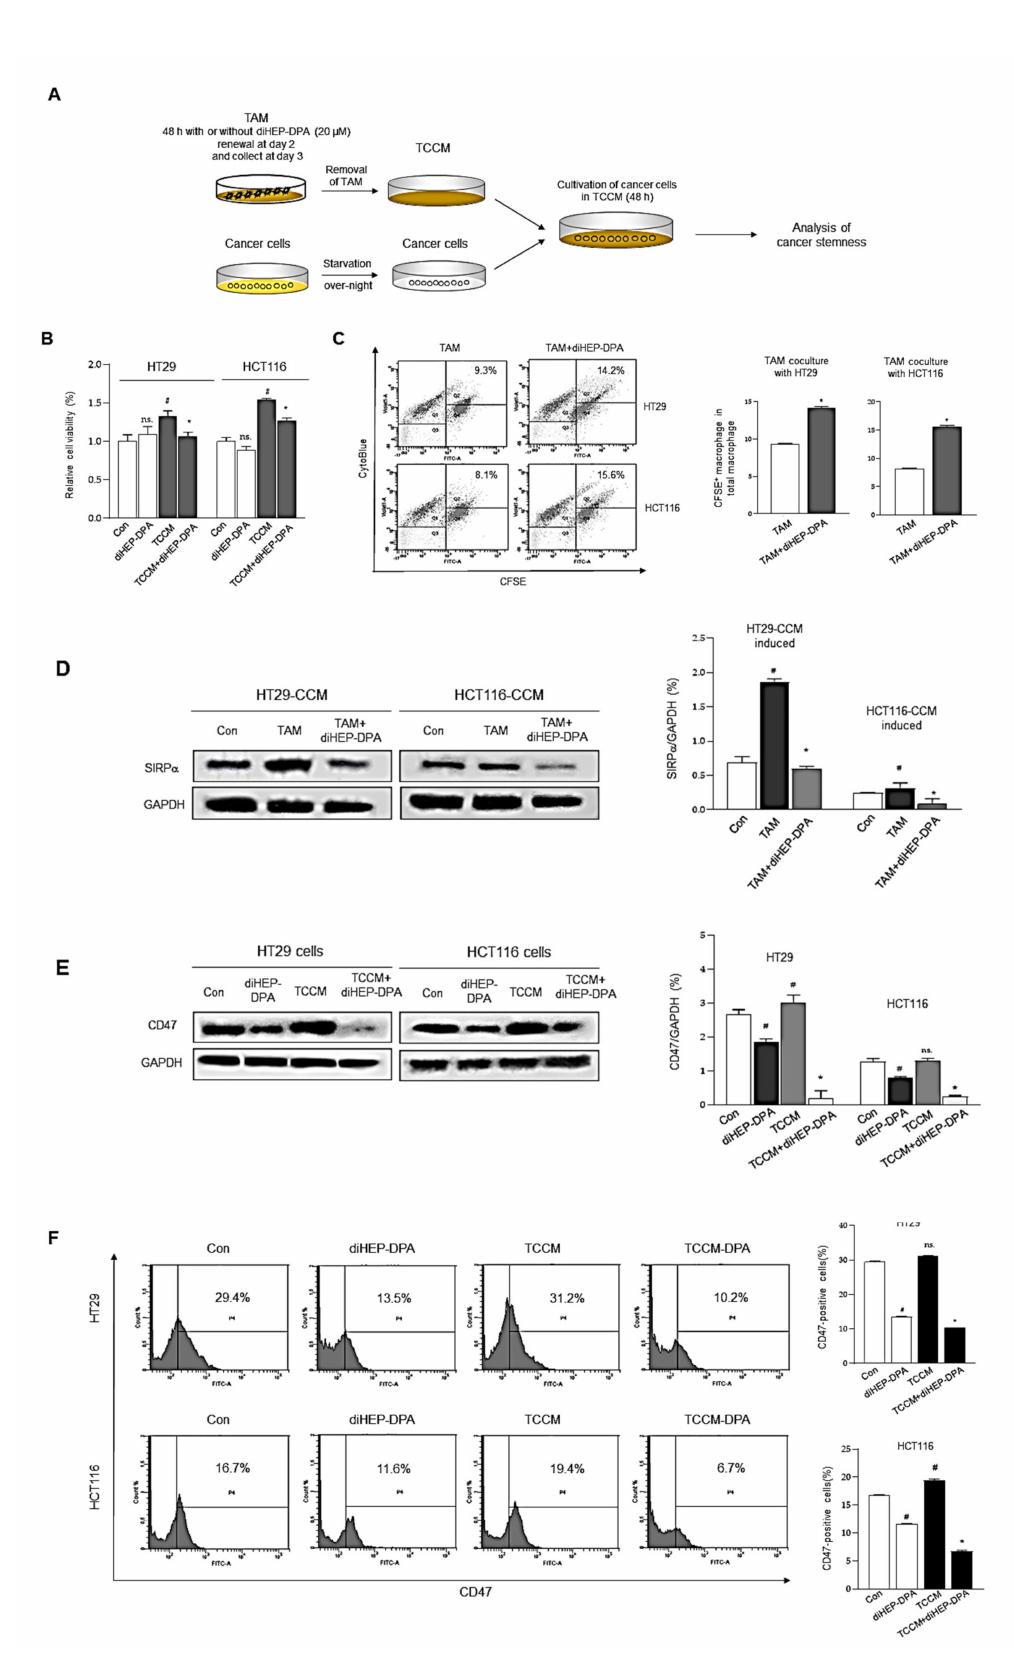
Figure 3. DiHEP-DPA effects on the proliferation and immunosuppression of colorectal cancer cells through modulation of TAM polarization. ( A ) Experimental procedure for treatment of colorectal cells with conditioned medium from TAMs